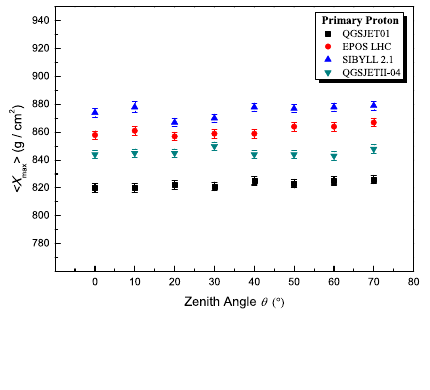
Figure 5. The variation of the charged maximum slant depth X max with the primary proton and iron nucleus energy for di ff er- ent high energy interaction models.